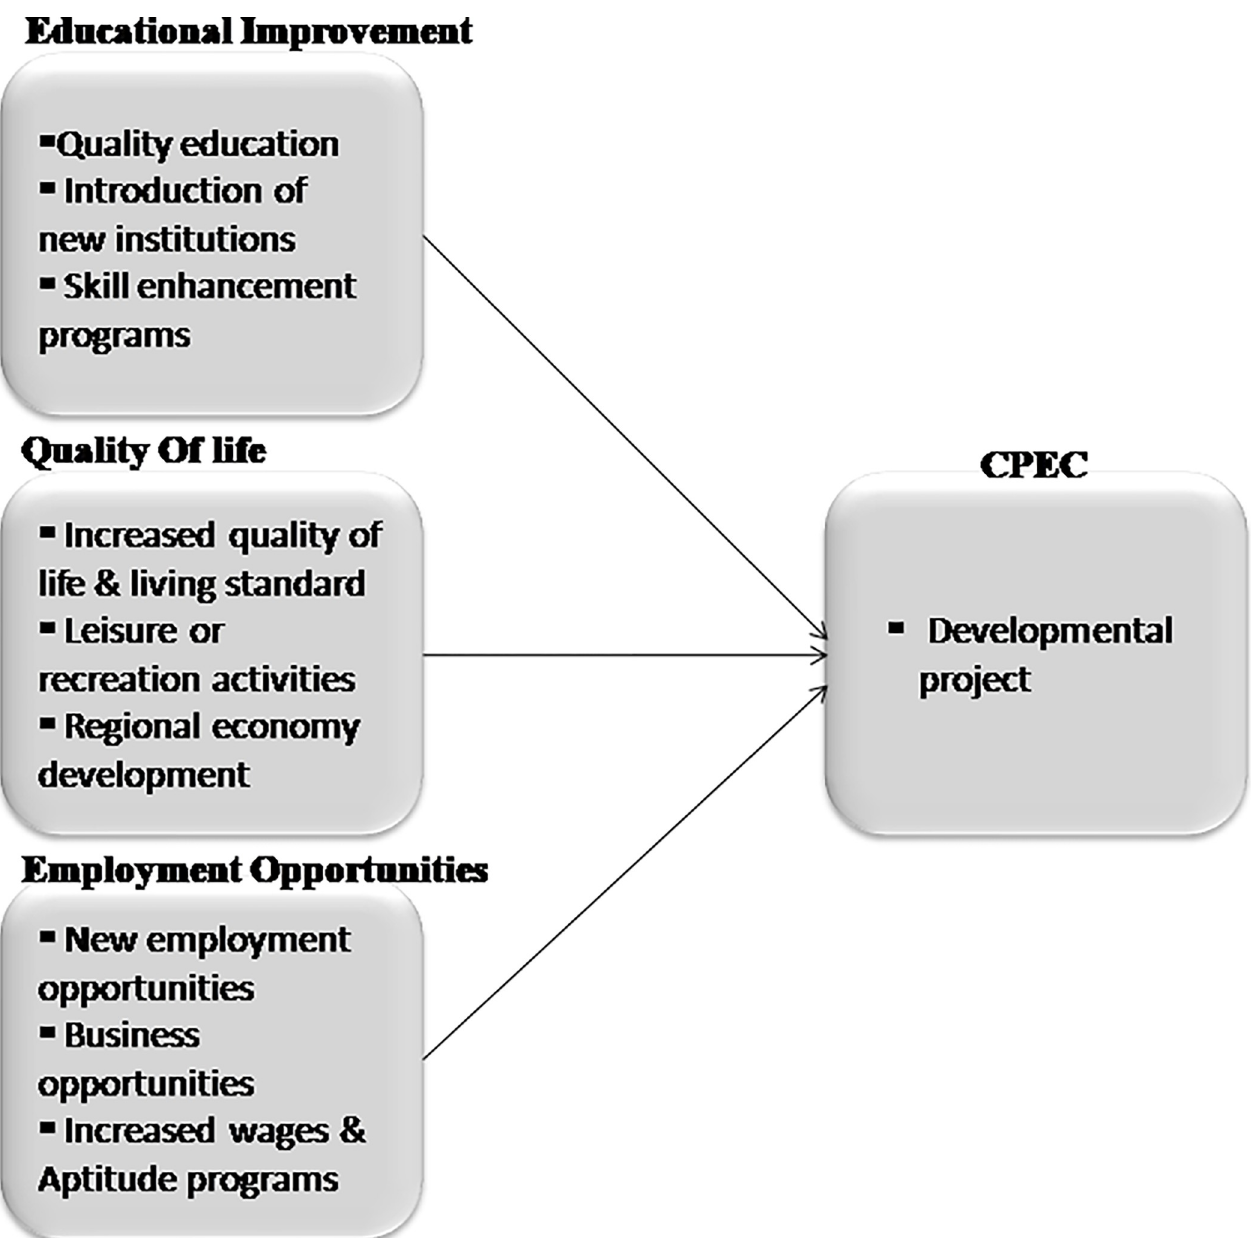
Fig 1. Conceptual